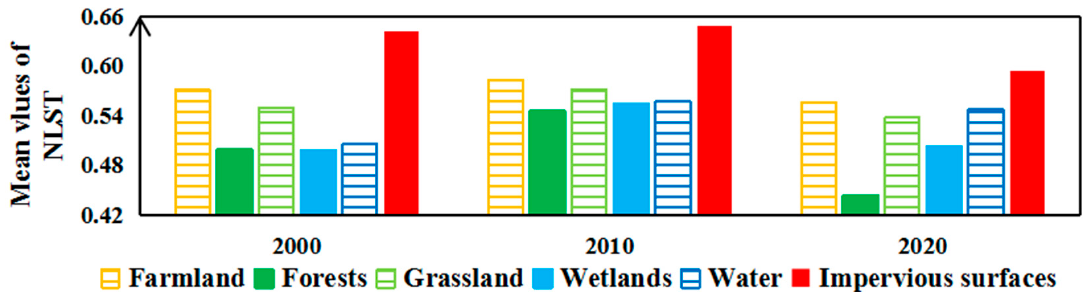
Figure 7. Mean values of NLST in Hangzhou City from 2000 to 2020.